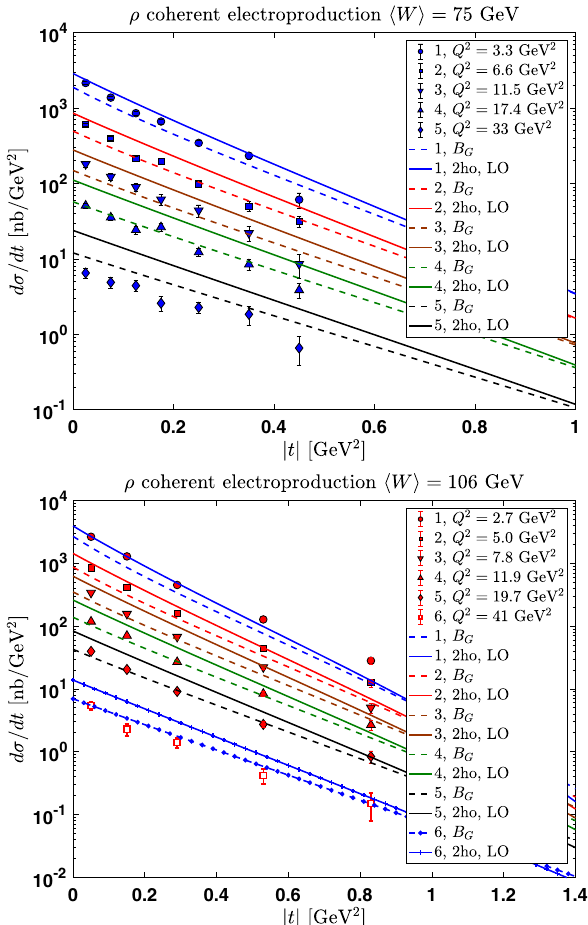
Fig. 12 Differential cross sections for coherent electroproduction of ρ mesons as afunction ofthe totalmomentum transfer(square) t . Thetwo set of data refer to the HERA experiments: H1 (upper panel) [40] and ZEUS (lower panel) [41]. The data are compared with present calcula- tions within the QMBA (2 h.o.) and the Gaussian ( B G ) approximation